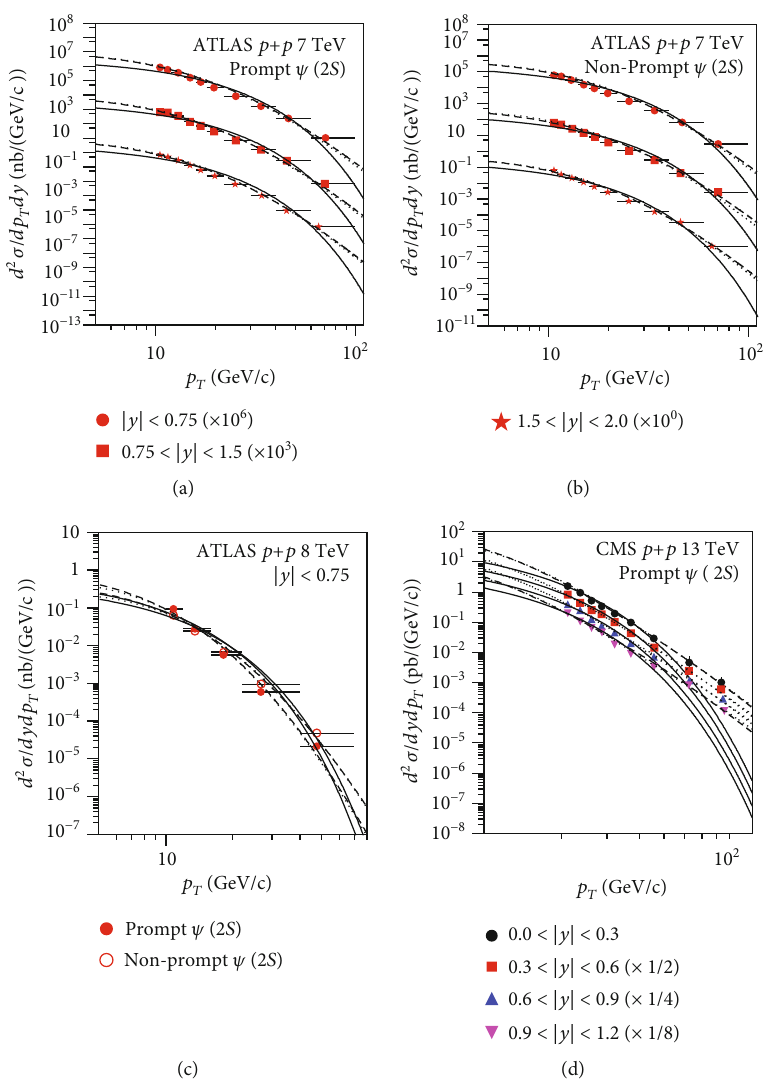
Figure 4: Same as Figure 3, but showing the results at (a, b) 7, (c) 8, and (d) 13TeV. The di ff erent symbols represent the experimental data of (a, d) prompt ψ ð 2 S Þ , (b) non-prompt ψ ð 2 S Þ , and (c) prompt ψ ð 2 S Þ and non-prompt ψ ð 2 S Þ measured by the (a – c) ATLAS [29, 30] and (d) CMS Collaborations [33] in (a, b) ∣ y ∣ <0 : 75 , 0 : 75 < ∣ y ∣ <1 : 5 , and 1 : 5 < ∣ y ∣ <2 : 0 , (c) ∣ y ∣ <0 : 75 , and (d) 0 : 0 < ∣ y ∣ <0 : 3 , 0 : 3 < ∣ y ∣ <0 : 6 , 0 : 6 < ∣ y ∣ <0 : 9 , and 0 : 9 < ∣ y ∣ <1 : 2 , where some data points are scaled by di ff erent amounts marked in the panels. The data points are fi tted by the Erlang distribution (Eq. (3), the solid curve), the Hagedorn function (Eq. (4), the dashed curves), and the Tsallis-Levy function (Eq. (6), the dotted curves). In particular, the two-component Hagedorn function (Eq. (5), the dashed curves) and the two-component Tsallis-Levy function (Eq. (7), the dotted curves) are used in Figure